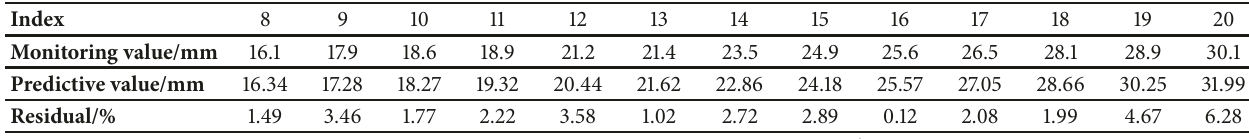
Table 6: The predictive value and the accuracy test results of rut.